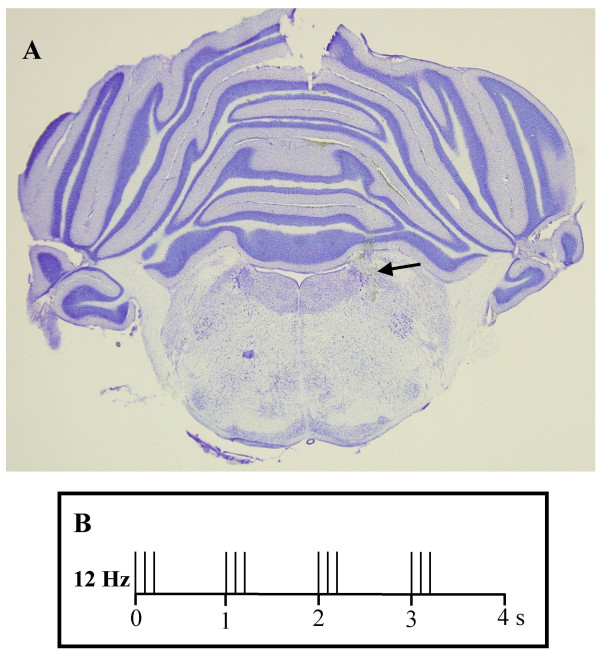
A: microphotograph showing the electrode localization into the locus coeruleus. B: schematic representation of locus coeruleus stimulation parameters; each vertical line represent a stimulus (700 μA, 250 μs), burst were delivered in 250 ms.